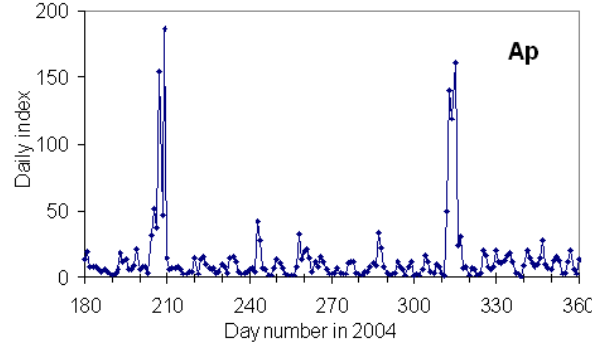
Fig. 3. Planetary index Ap from July to December